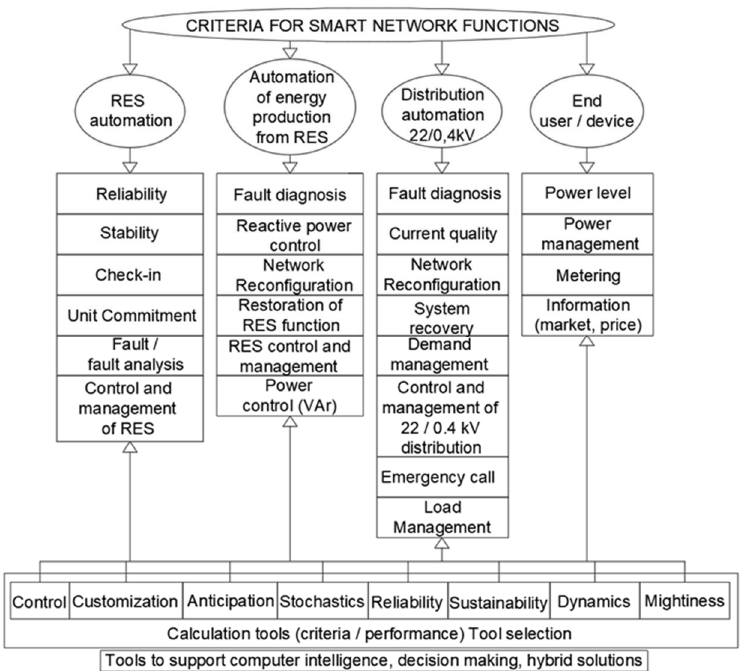
Figure 4. Smart grid using advanced techniques for optimization, control and management [34].